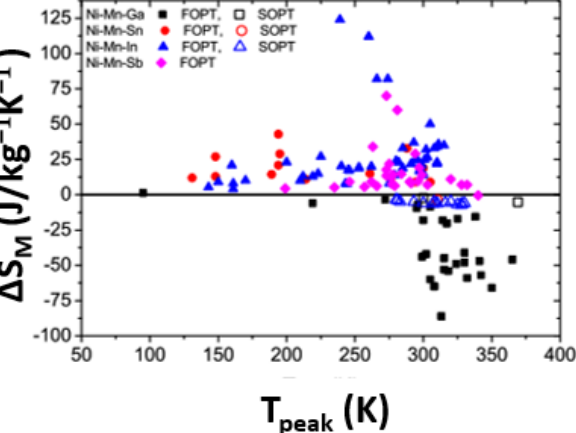
Figure 4. ∆ S M values for several Heusler alloys as a function of peak temperatures (T peak ) at 5 T. Reprinted with the permission from refs. [65–68]. Copyrights 2008, 2009 and 2016 Elsevier.